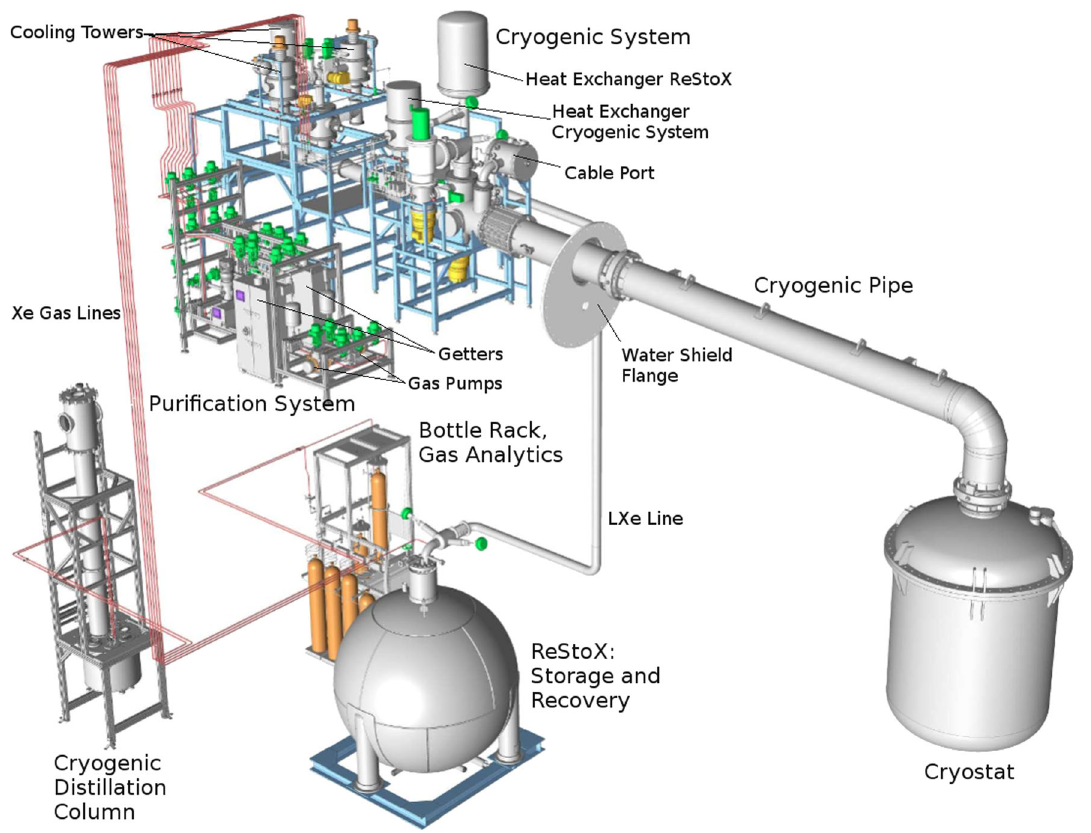
Fig. 9 The gas-handling system of XENON1T consists of the cryo- genic system (cooling), the purification system (online removal of electronegative impurities), the cryogenic distillation column ( nat Kr removal), ReStoX (LXe storage, filling and recovery), the gas bottle